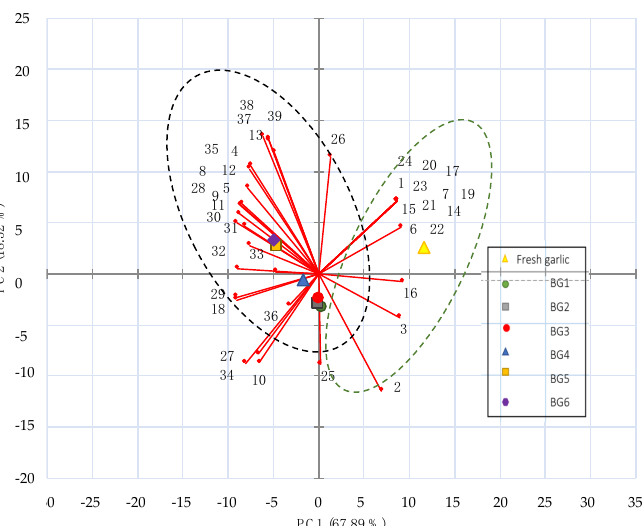
Figure 6. Principal component analysis analyses of the analysed metabolites of garlic samples. BG1, BG2, BG3, BG4, BG5 and BG6 were processed from fresh garlic with different iMC (BG1, BG2, BG3, BG4, BG5 and BG6 with 72.60%, 66.78%, 59.99%, 56.44% 51.15% and 49.95%, respectively). The numbers are correspondent with active compounds as reported in Table 1.